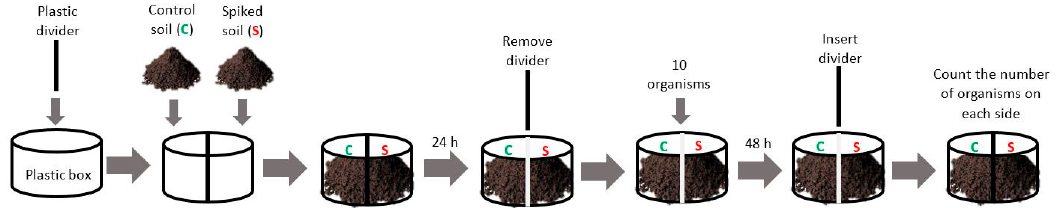
Figure 1. Schematic representation of the avoidance assay performed.